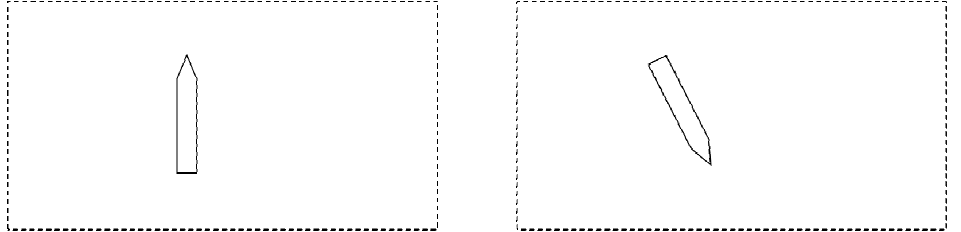
Figure 3. Different dynamics inferred by the inclination of the geometry. Inspired by Kandinsky’s work ([22]).